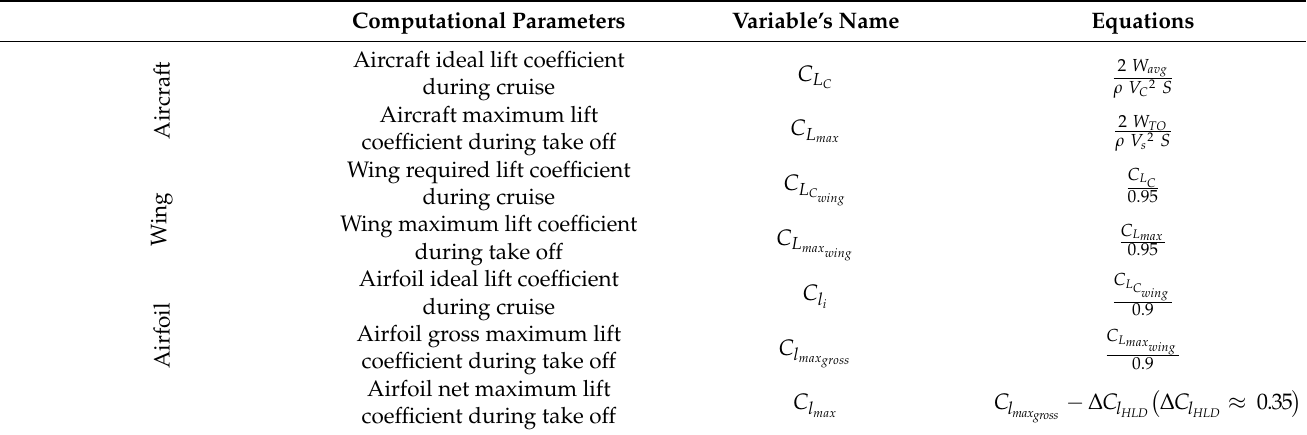
Table 2. Aircraft, wing and airfoil lift coefficients.